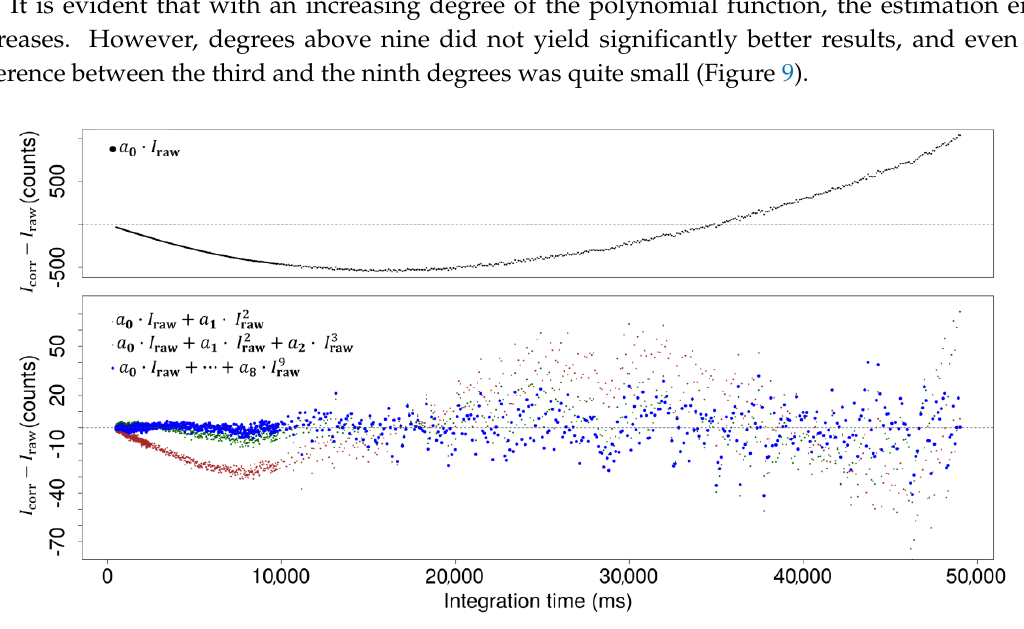
Figure 9. Differences between corrected and referential intensities for selected polynomials ( I corr − I raw ; Y-axis) versus integration time (ms). The panel above shows a wider range of intensity counts for the first-degree polynomial function, while the panel below shows a narrower range for the second-, third-, and ninth-degree functions.